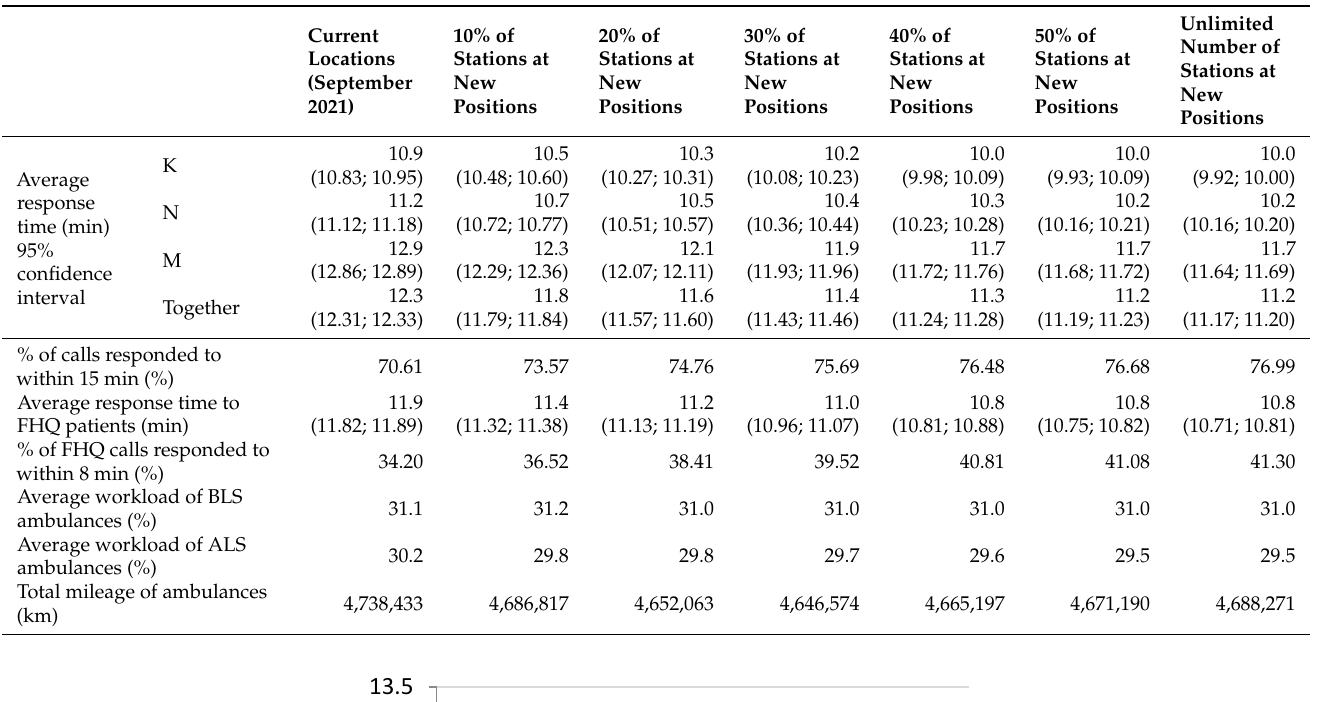
Table 3. Simulation results.